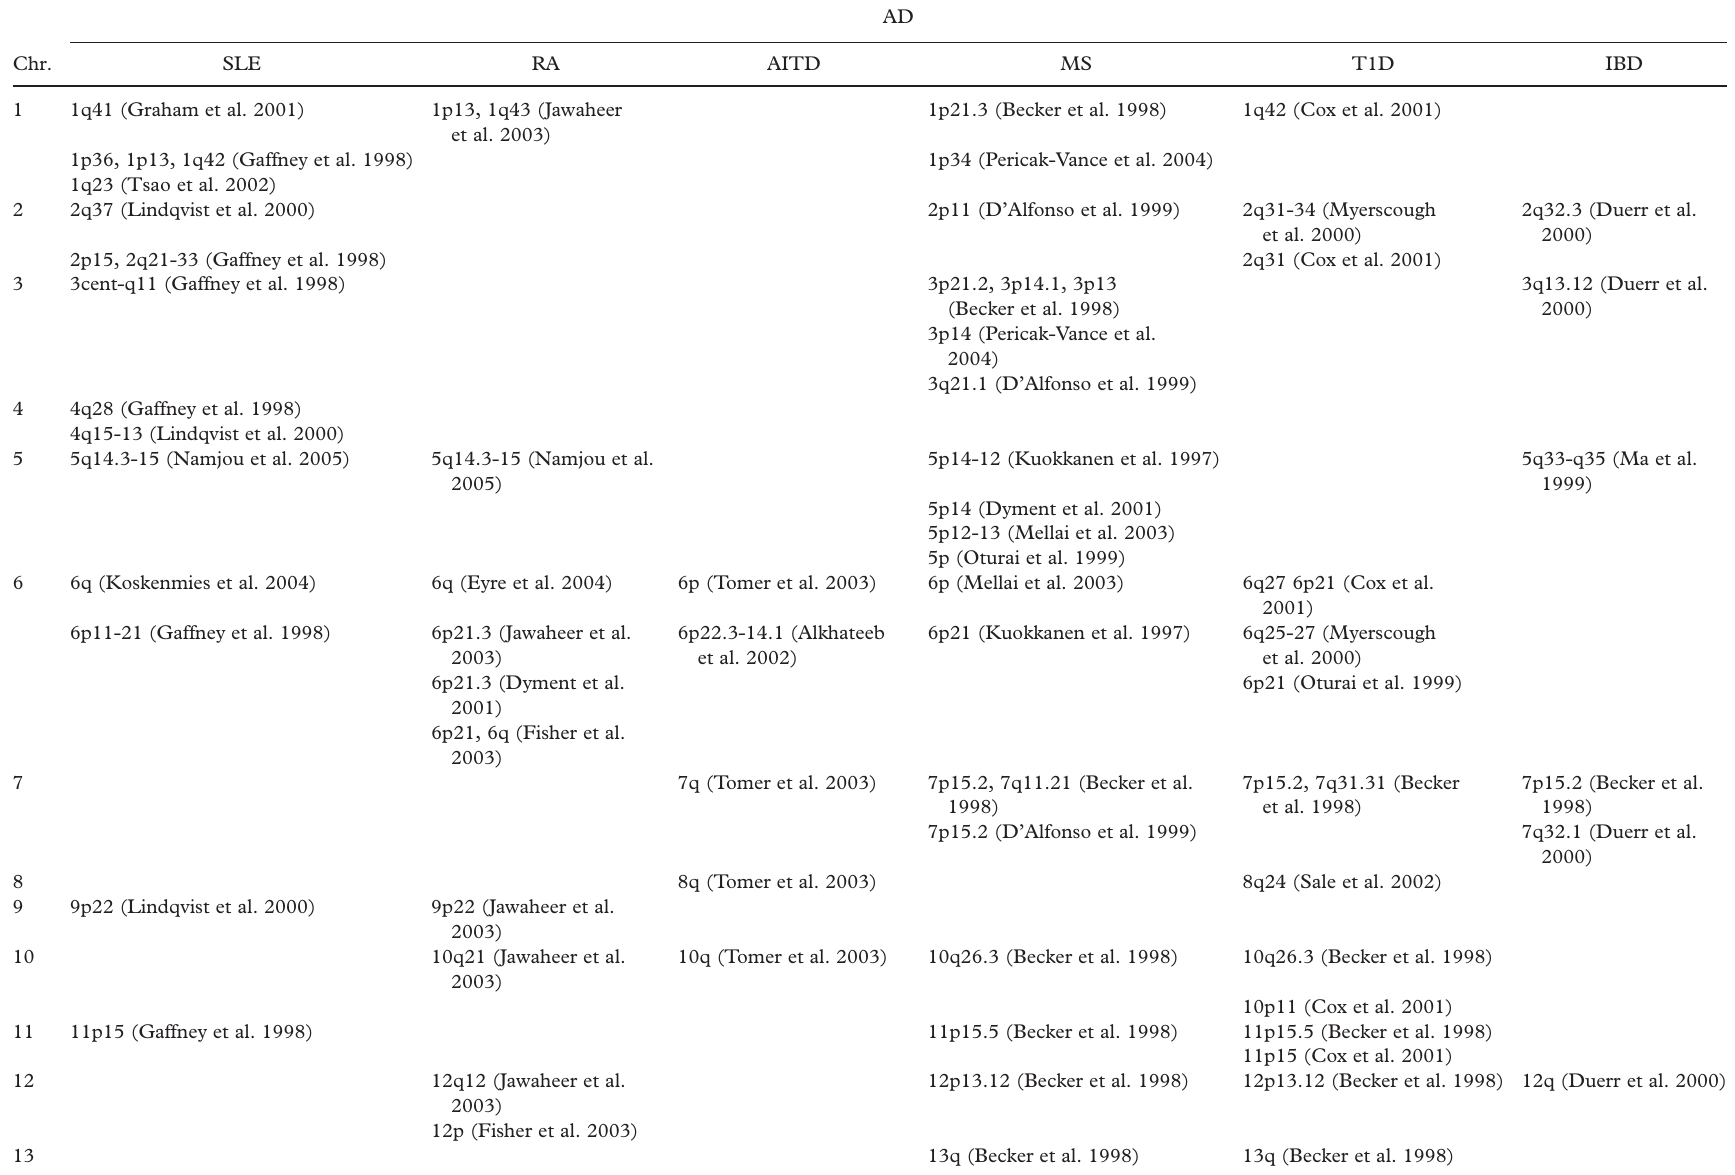
Table III. Chromosomal regions associated or linked with autoimmune traits.